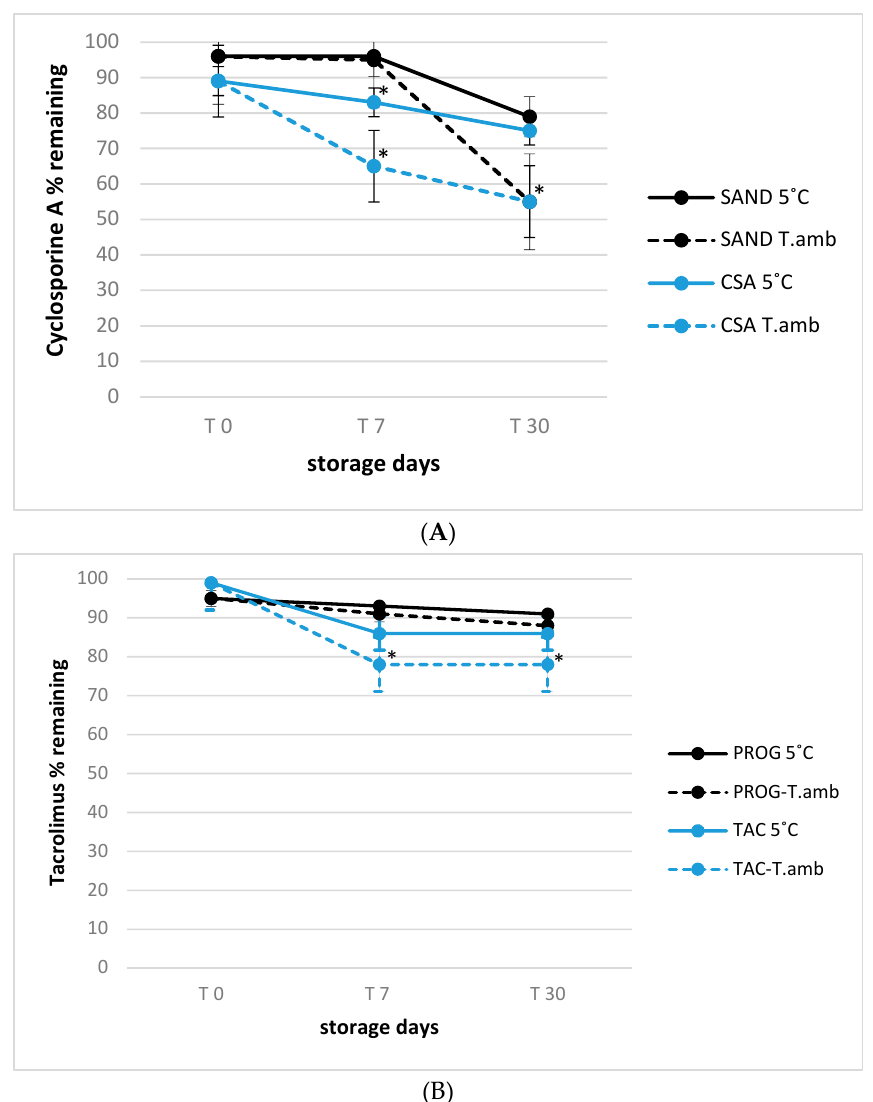
Figure 5. ( A ) 1.0% cyclosporine A formulations stability for 30 days shelf-life after 60 days unopened storage; * p < 0.05, T.amb versus 5 °C storage temperature. ( B ) 0.1% tacrolimus formulations stability